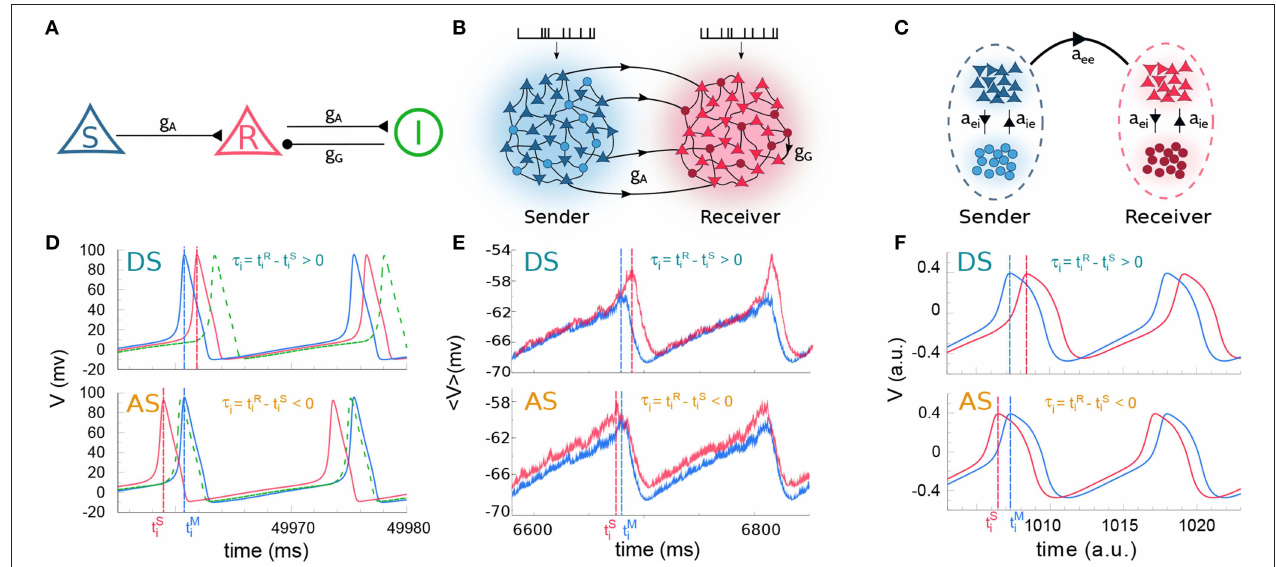
FIGURE 1 | Cortical motif circuits. Schematic representation of the models: (A) 3-neuron motif, (B) two cortical populations, and (C) two neural masses. (D) Membrane potential of three neurons in a regime of delayed-synchronization (DS, top) and anticipated-synchronization (AS, bottom). (E,F) Average membrane potential in a regime of DS (top) and AS (bottom), for populations and neural masses, respectively. For the sake of clarity, the data in (D–F) correspond to simulations where the external parameter was varied. The parameters used were: (D) g G = 20.0 nS with I R ext = 280 pA (DS) and I R ext = 320 pA (AS); (E) g G = 8.0 nS with λ R Ext = 2.8 kHz (DS) and λ R Ext = 3.0 kHz (AS); (F) g G = 1.4 with I R ext = 0.1 (DS) and I R ext = 0.75 (AS). For (A–C) excitatory and inhibitory neurons are represented by triangle and circle, respectively. Also, the colors used in (D–F) , respectively, stand for the same colors as in (A–C)